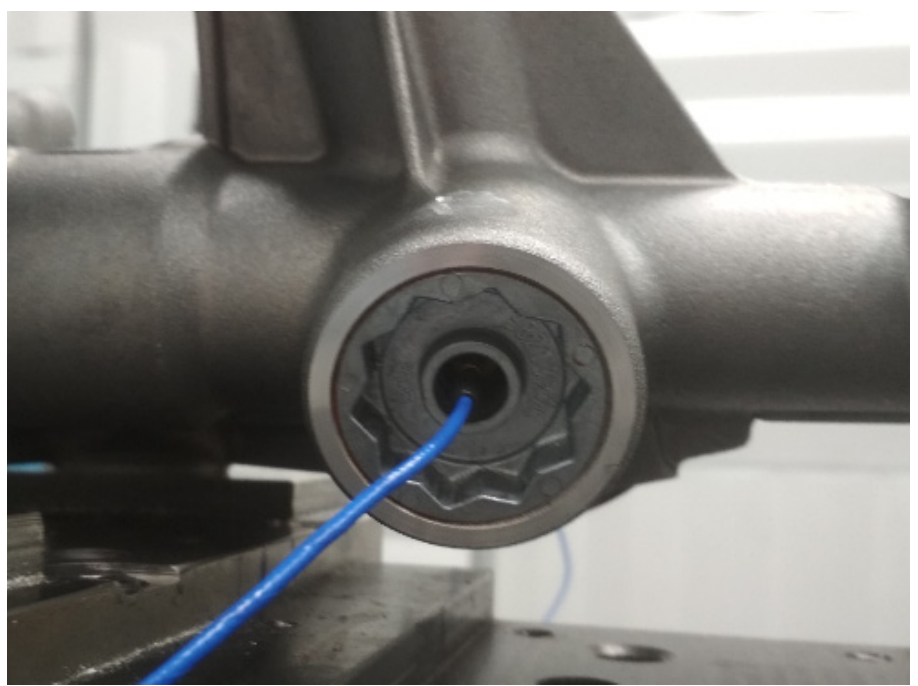
Figure 7. CRB accelerometer mounting arrangement.